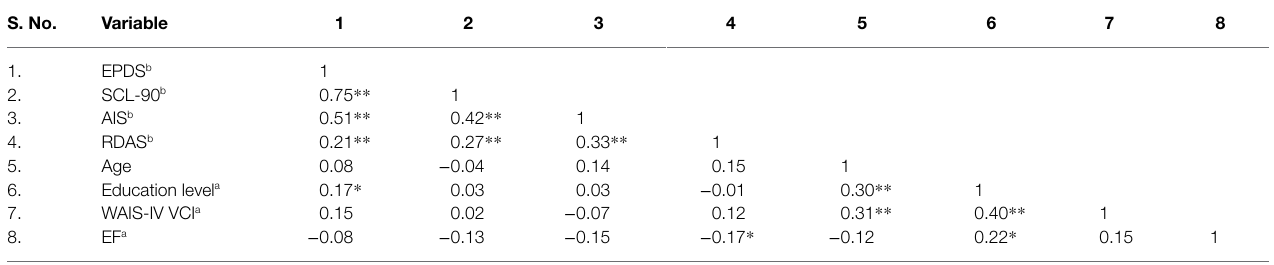
TABLE 3 | Bivariate correlations between variables. S.